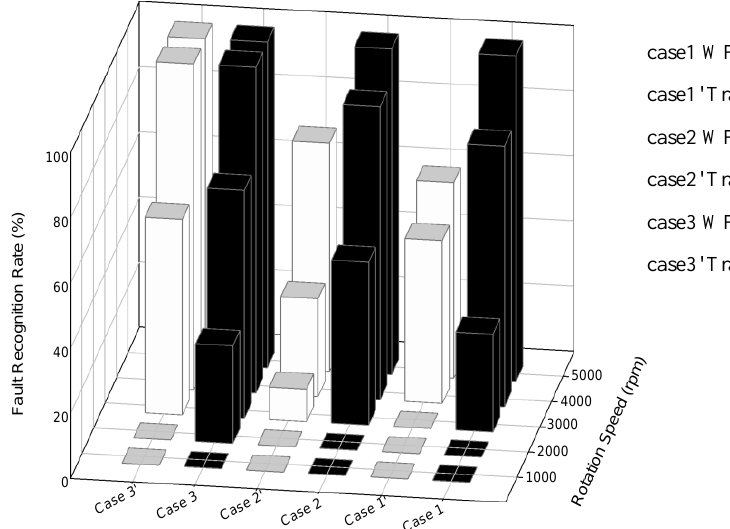
Figure 12. The WPMS provides a higher fault recognition rate than the traditional method